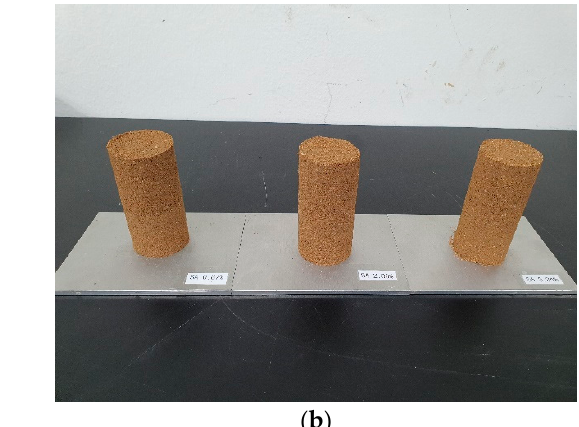
Table 4. Shear modulus of reinforced soil in resonant-column test. G max : maximum shear modulus. Mixing Mate- rial